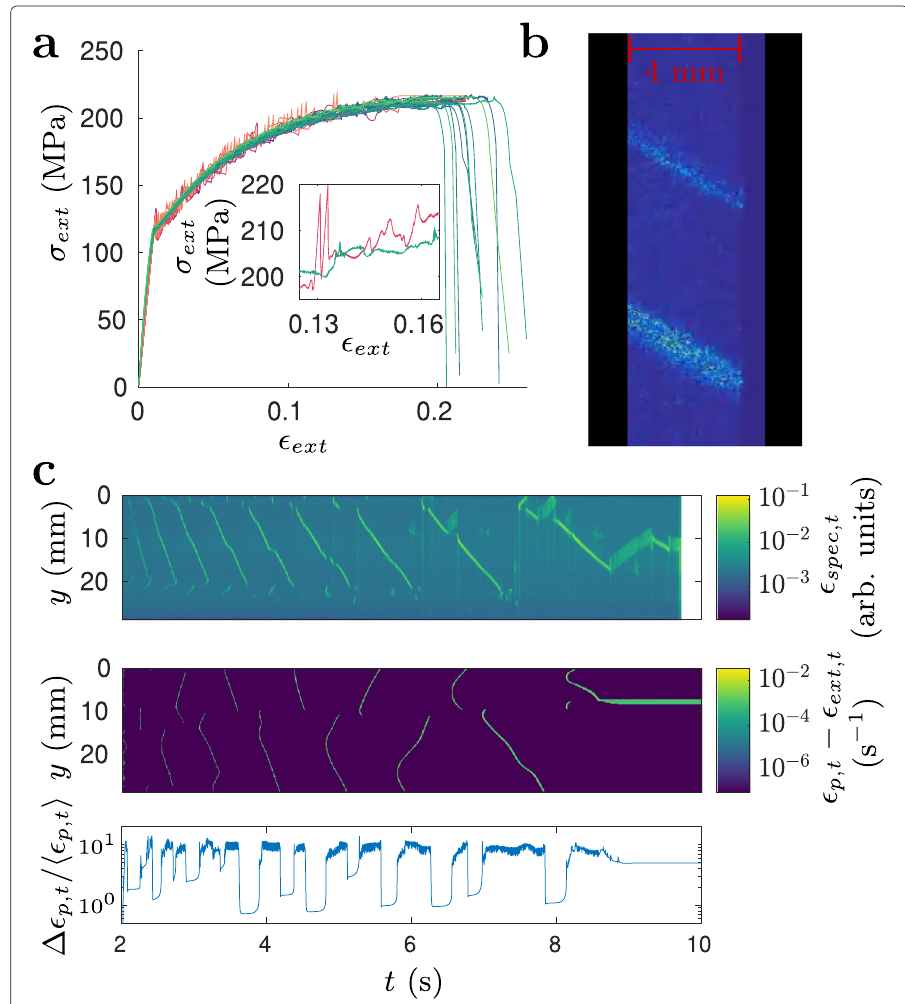
Fig. 1 a The stress-strain curves showing the responses from experiments (green) and simulations (red) superimposed. The Inset shows the stress serrations in magnified view. b The raw subtracted speckle images showing two simultaneous PLC bands. c Two strain rate maps showing the experimental effective strain rate (cid:2) spec , t (top) for one band inclination and for comparison the difference of plastic strain rate strain rate (cid:2) ext , t during a simulation done with the same strain rate. Below the relative standard deviation of the plastic strain rate in the simulation